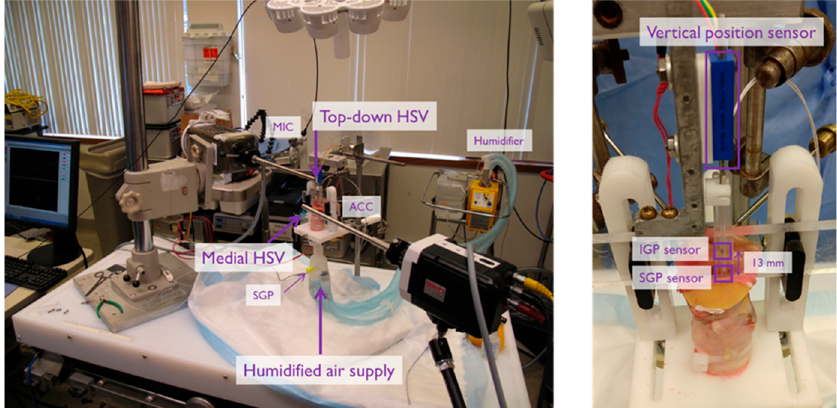
Figure 6. Hemilarynx experimental setup with dovetailed slider incorporating intraglottal (IGP) and subglottal (SGP) pressure sensors. IGP and SGP sensor signals were synchronized with data from the top–down high-speed video (HSV) camera, medial HSV camera, an acoustic microphone (MIC), tracheal-surface accelerometer (ACC), and a relative vertical position sensor.